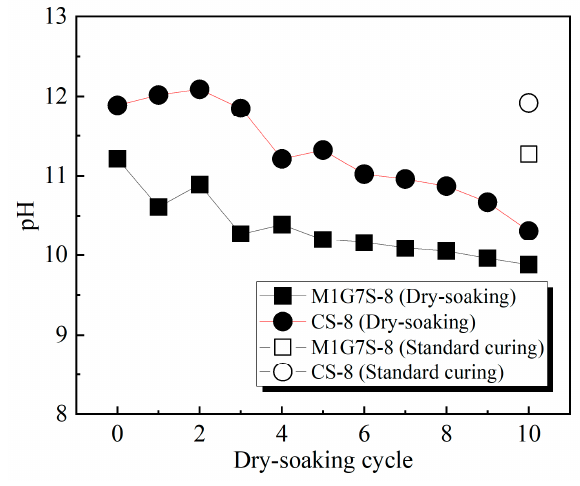
Figure 9. Variations of pH with dry–soaking cycle for shield residues stabilized by M1G7-8 and CS-